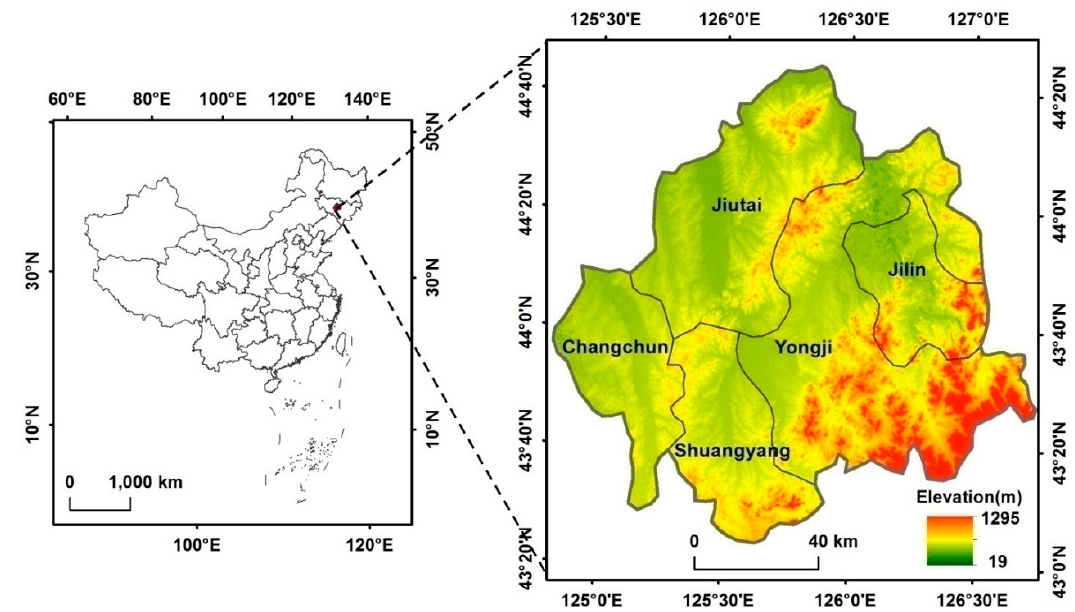
Figure 1. Location of the Changchun–Jilin Economic Zone (CJEZ).